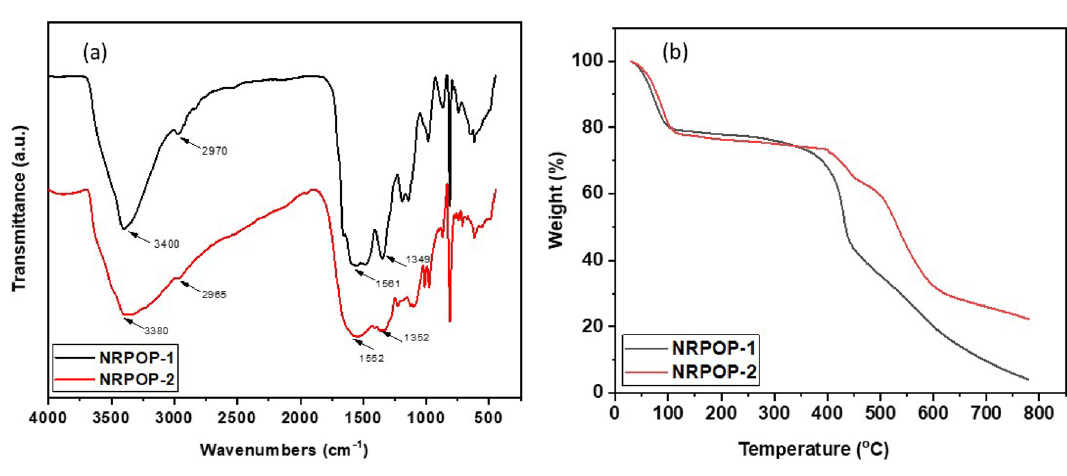
Figure 1. FTIR spectra ( a ) and TGA ( b ) of NRPOP-1 and